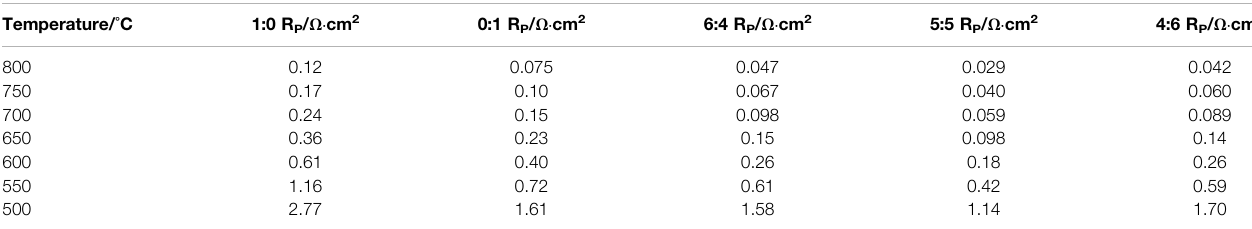
TABLE 2 | Rp values of PSFN 113 and PSFN 214 cathode oxides with different mass ratios. Temperature/ °